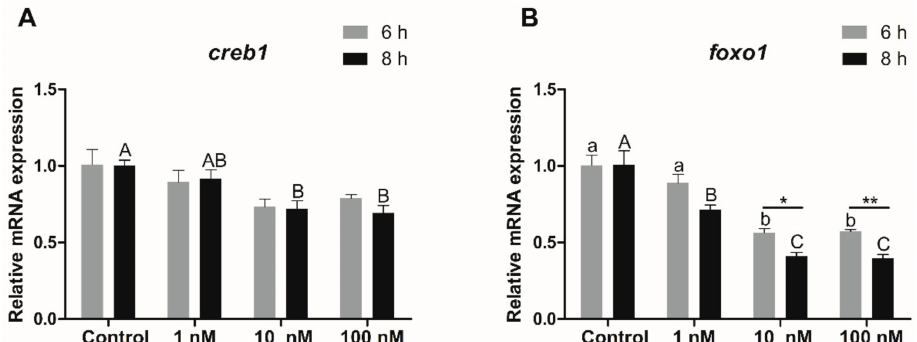
Figure 9. The transcriptional expression of creb1 ( A ) and foxo1 ( B ) in hepatocytes of rainbow trout treated with graded amounts of insulin. Control group was selected as normalization. Data were presented as means ± S.E.M. (n = 3). Capital letters show the di ff erences in the 8 h group. Lowercase letters show the di ff erences in the 6 h group. Means that share the same superscript letter are not significantly di ff erent ( p > 0.05). * p < 0.05; ** p <